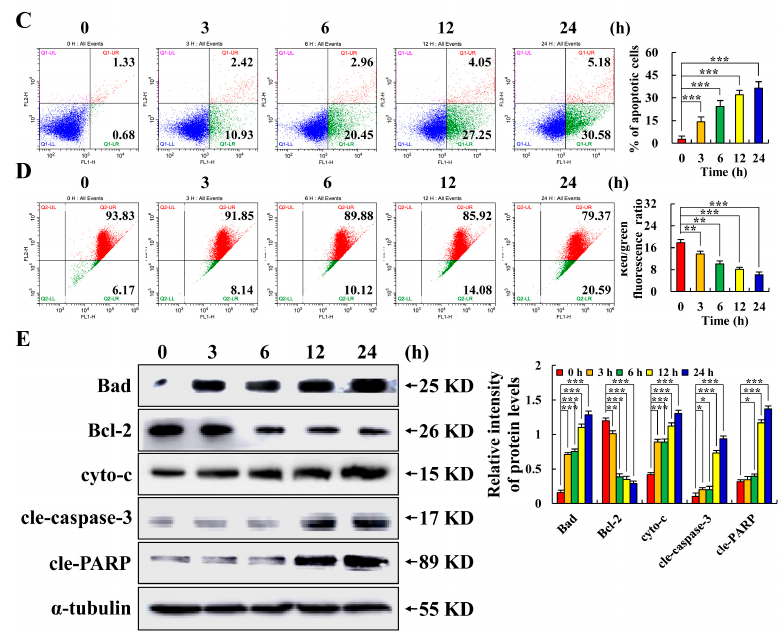
Figure 2. Apoptotic effects of ISO in AGS cells. A total of 36.54 µM ISO was applied to AGS cells from 0 to 24 h. ( A ) AGS cells after Hoechst and PI staining were observed by fluorescence microscope (original magnification, × 200). ( B ) AGS cells after Annexin V and PI staining were observed by fluorescence microscope (original magnification, × 400). ( C ) Apoptosis rate of AGS cells. ( D ) Flow cytometry was used to calculate the mitochondrial membrane potential. ( E ) Expression levels of apoptosis–related proteins in AGS cells treated with ISO. The α –tubulin was used as an internal reference protein. * p < 0.05, ** p < 0.01 and *** p < 0.001 vs. 0